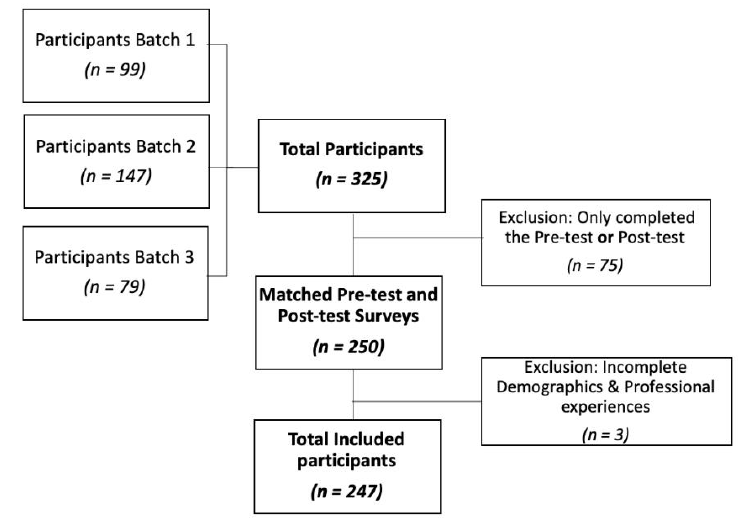
Figure 1. Flow diagram of the included participants.